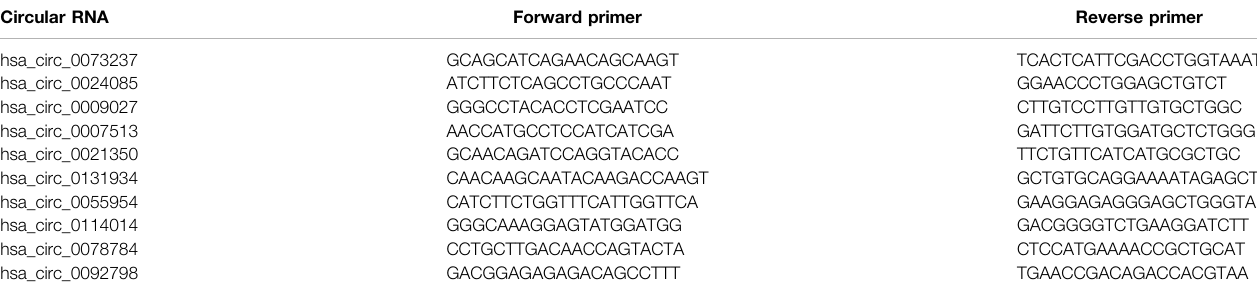
TABLE 1 | The primers of circular RNAs. Circular